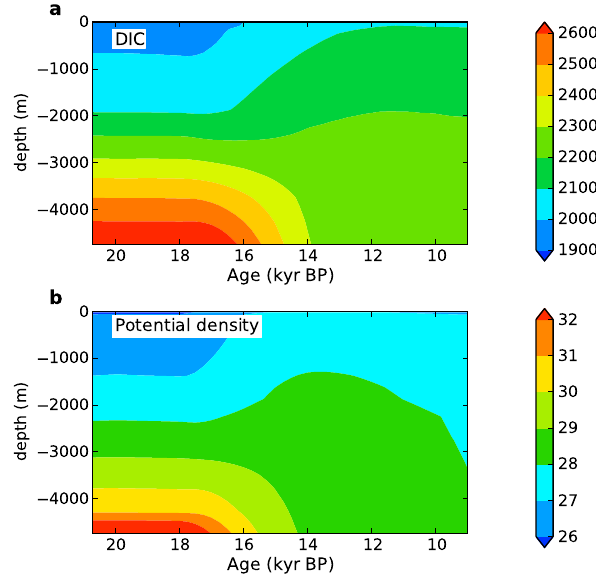
Fig. 15. Evolution of (a) Dissolved Inorganic Carbon (DIC, µmolkg − 1 ) and (b) potential density anomaly ( ρ θ − 1000kgm − 3 ) as a function of depth at latitude 50 ◦ S of the Atlantic ocean